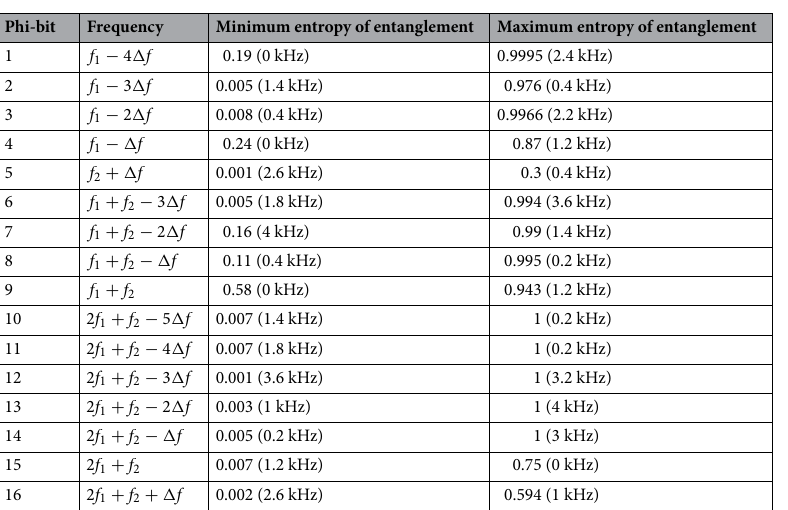
Table 1. List of logical phi-bits, as identified in Fig. 1b. The phi-bits are listed in the order of increasing frequencies. Columns 3 and 4 list the minimum and maximum entanglement entropy values for single phi-bit traced state. Detuning frequencies corresponding to these maxima and minima are shown